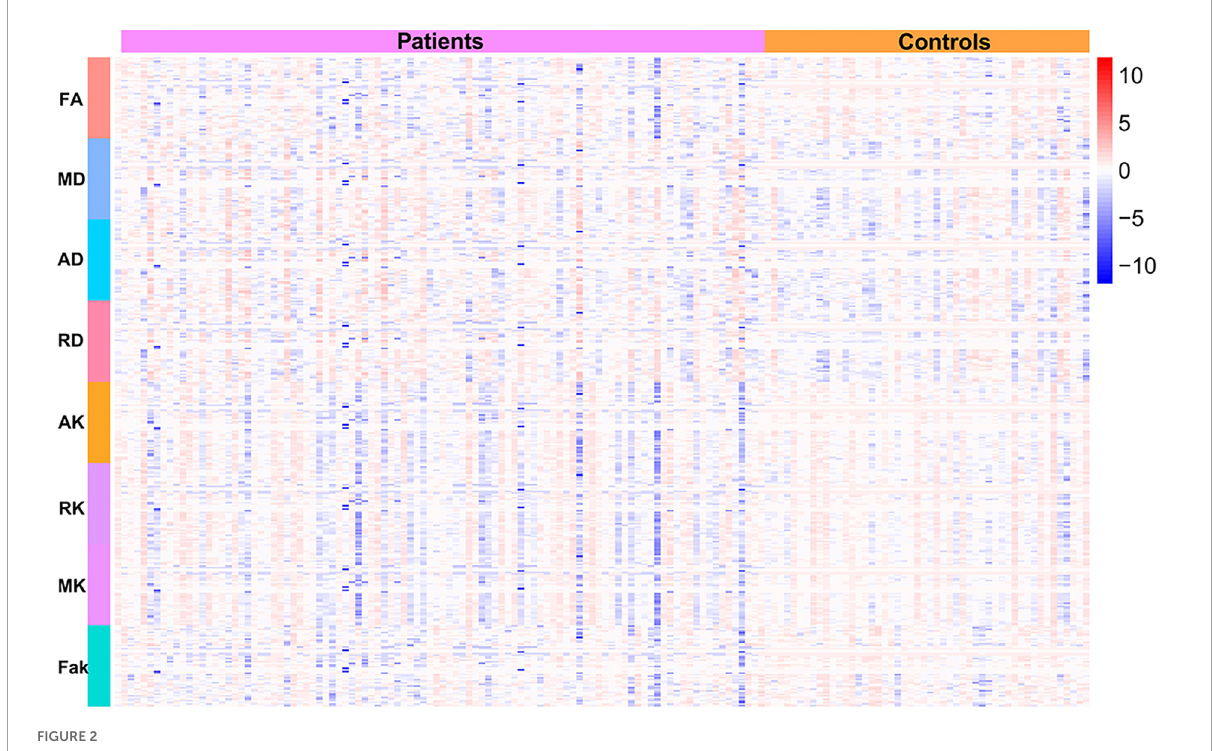
FIGURE2 Heat map of the DKI-derived values in 150